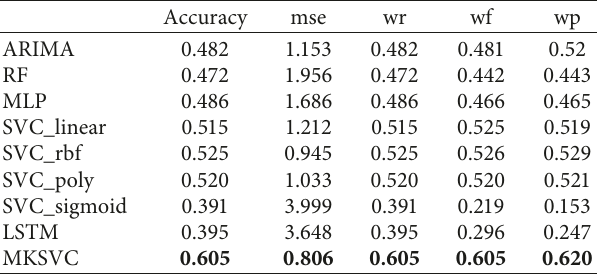
Table 16: Performance comparison for predicting the future 12 hour’s PM2.5 IAQL in